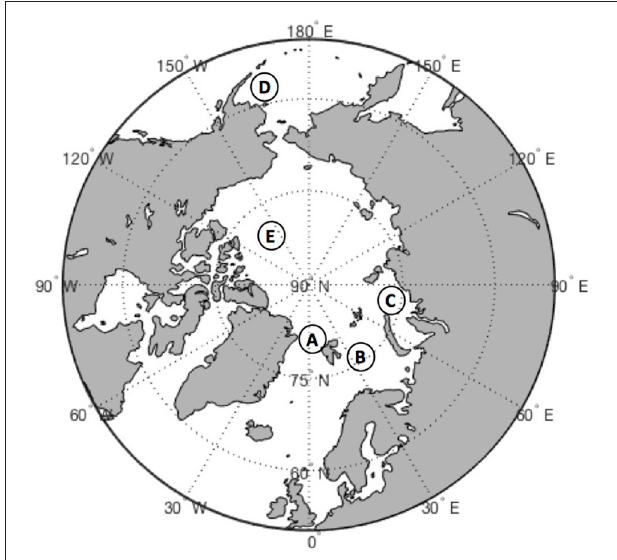
FIGURE 1 | Map of the Arctic Ocean showing the main study locations: A, Fram Strait; B, Barents Sea; C, Kara Sea; D, Bering Sea; E, Canada